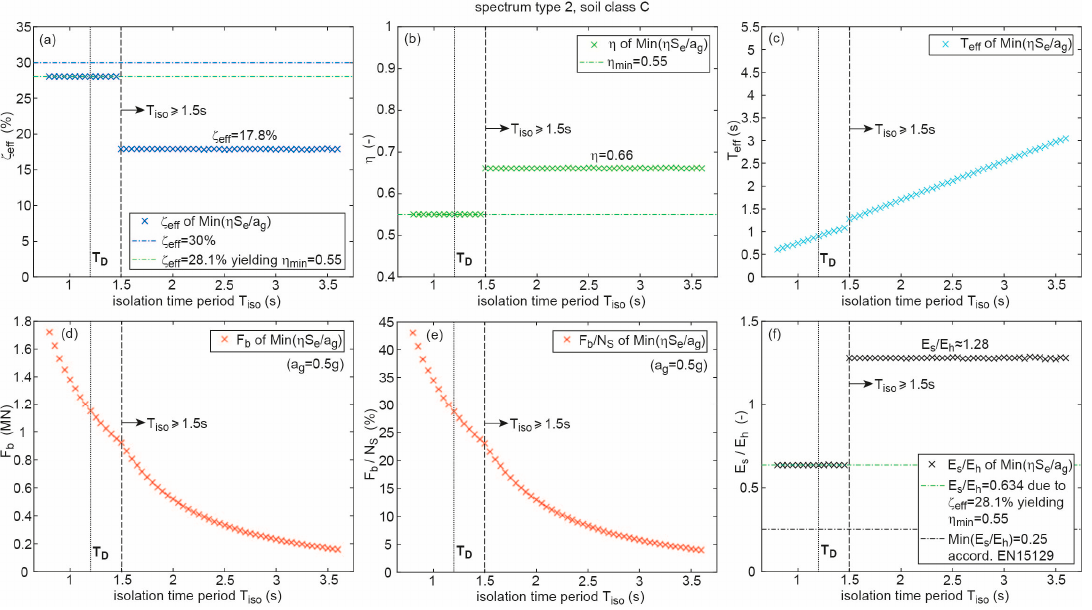
Figure 13. States of optimum solution: ( a ) effective damping ratio; ( b ) reduction factor; ( c ) effective time period; ( d , e ) maximum horizontal CSS force; ( f ) re-centring condition for spectrum type 2 with soil class C.